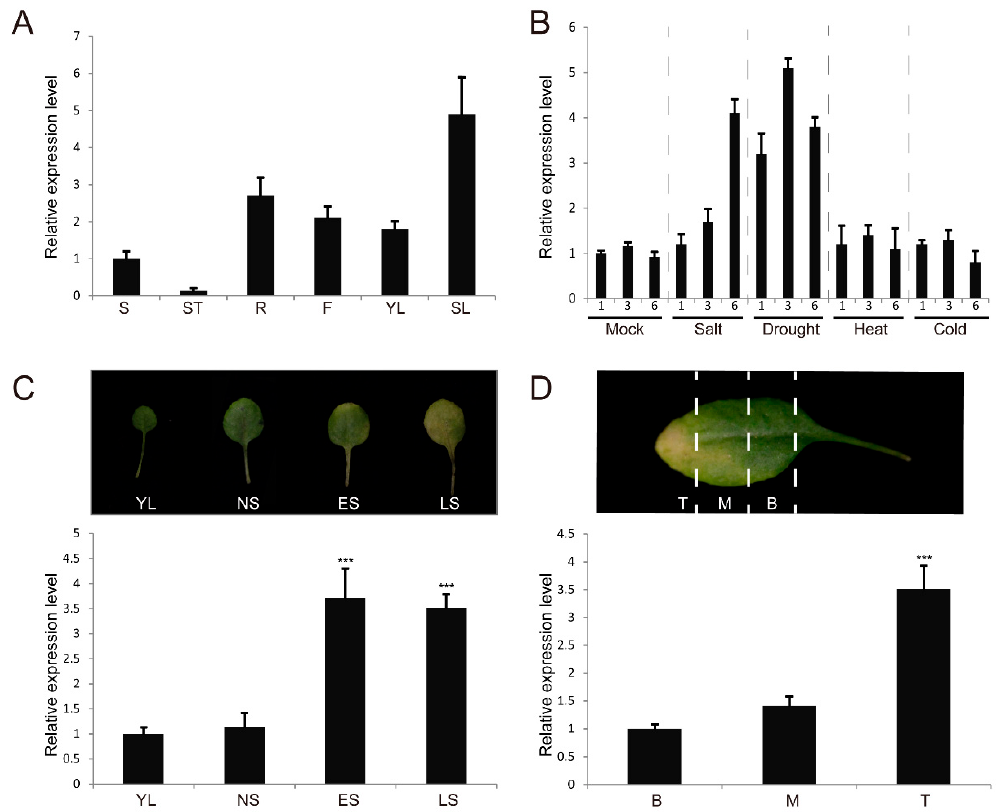
Figure 1. Expression analysis of the SERK4 gene: ( A ) SERK4 expression levels in tested tissues. The ratios of SERK4 gene expression level in different tissues were calculated relative to the shoot. S, shoot; St. shoot tip; R, root; F, flower; YL, young leaf; SL, senescence leaf; ( B ) SERK4 gene expression changes under abiotic stress treatments. The ratios of SERK4 gene expression level under tested treatments were calculated relative to the untreated seedlings; ( C ) SERK4 gene expression in leaves at different developmental stages. The ratios of SERK4 gene expression level were calculated relative to the YL stage. YL, young leaf; NS, fully-expanded, non-senescent leaf; ES, early senescent leaf; LS, late senescent leaf; ( D ) SERK4 gene expression at different sections of a senescing leaf. The ratios of SERK4 gene expression level were calculated relative to the base section. B, base; M, middle; T, tip. In A, B, C and D, the expression data are means ± SD of three biological repeats. *** p < 0.001 ( t